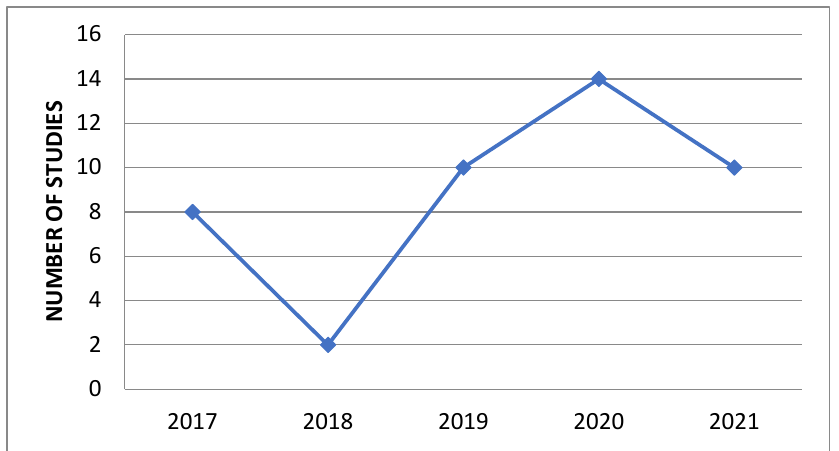
Figure 3. Trend in the number of studies published by year between 2017 ‐ 2018 and 2019 ‐ 2021.